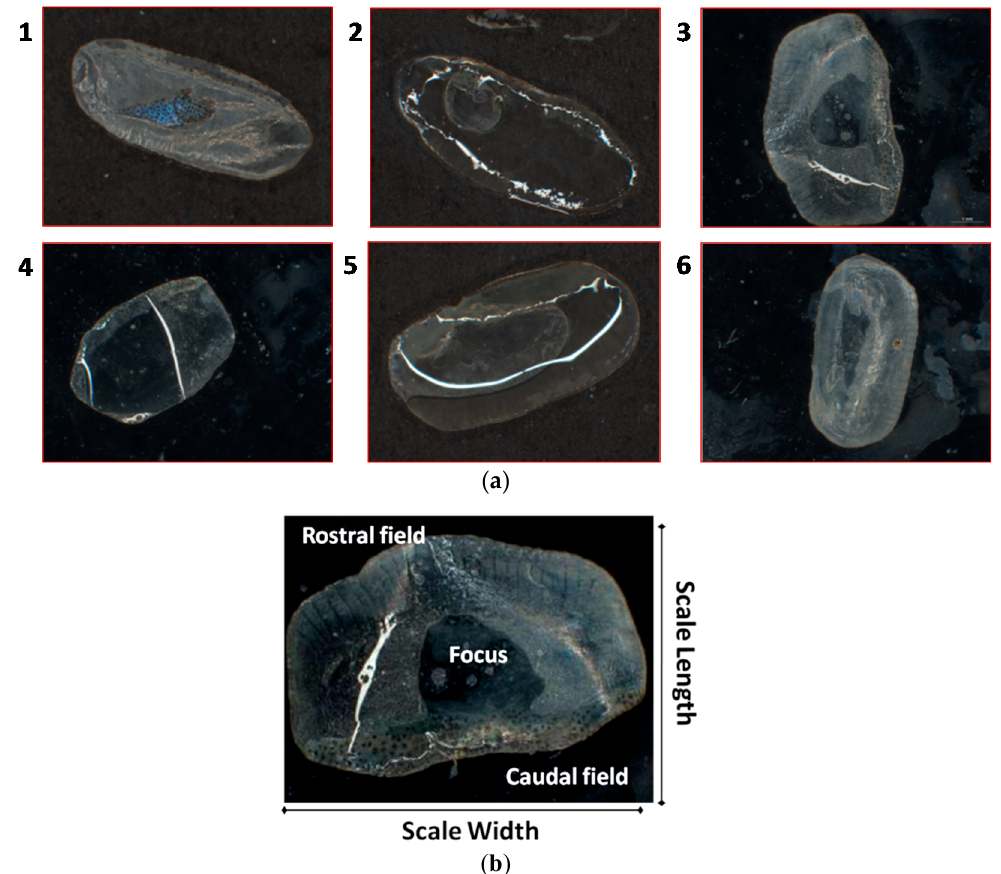
Figure 2. ( a ) Optical images of representative scales from each region: 1 (operculum), 2 (dorsal), 3 (upper-peduncle), 4 (low-peduncle), 5 (anal), 6 (pectoral); ( b ) Gilthead seabream scale from this study, where length and width are labeled.